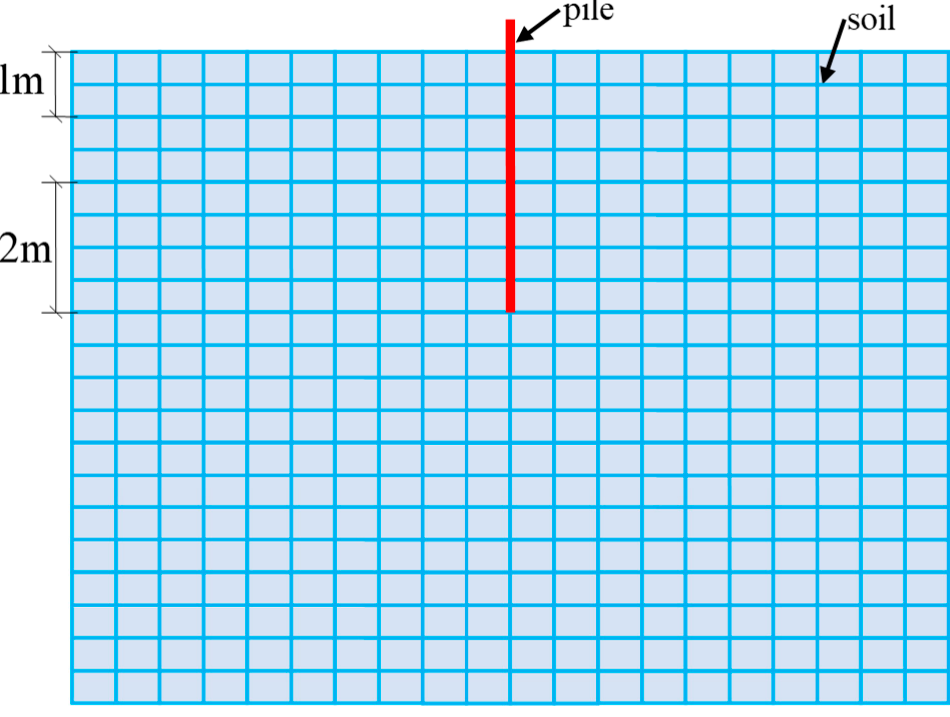
Figure 5. Finite-element (FE) model of laterally loaded pile. Table 2. Parametric properties of the